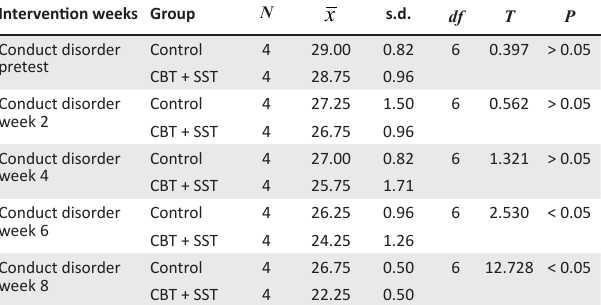
However, during week 6 of the intervention, participants in experimental groups (CBT + SST) ( x = 24.25, s.d. = 1.26)